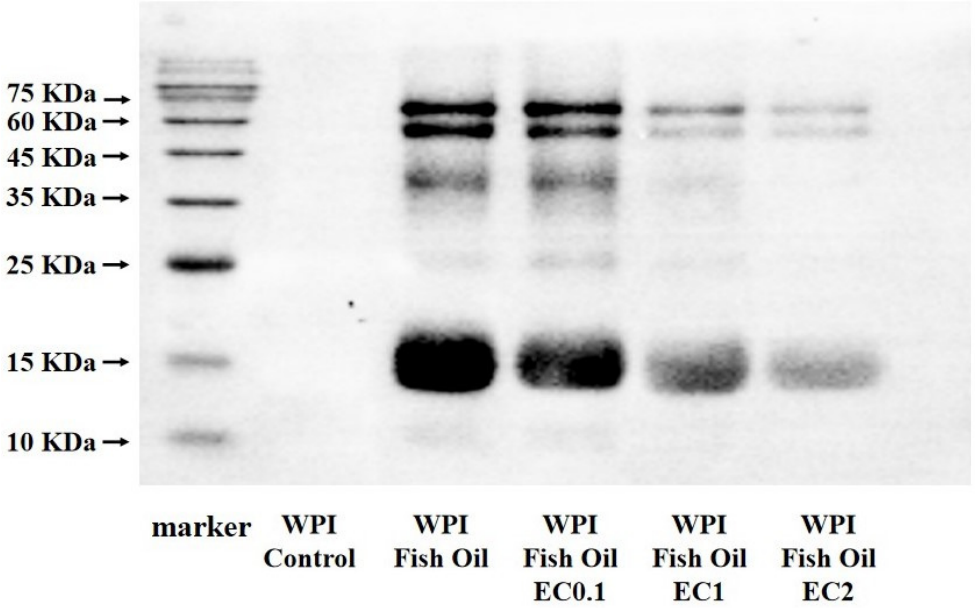
Figure 5. Western bolt analysis of MDA-bound proteins in WPI in fish oil-fortified emulsions incubated at 25 °C for 24 h in the absence or presence of EC (0.1~2 mM).